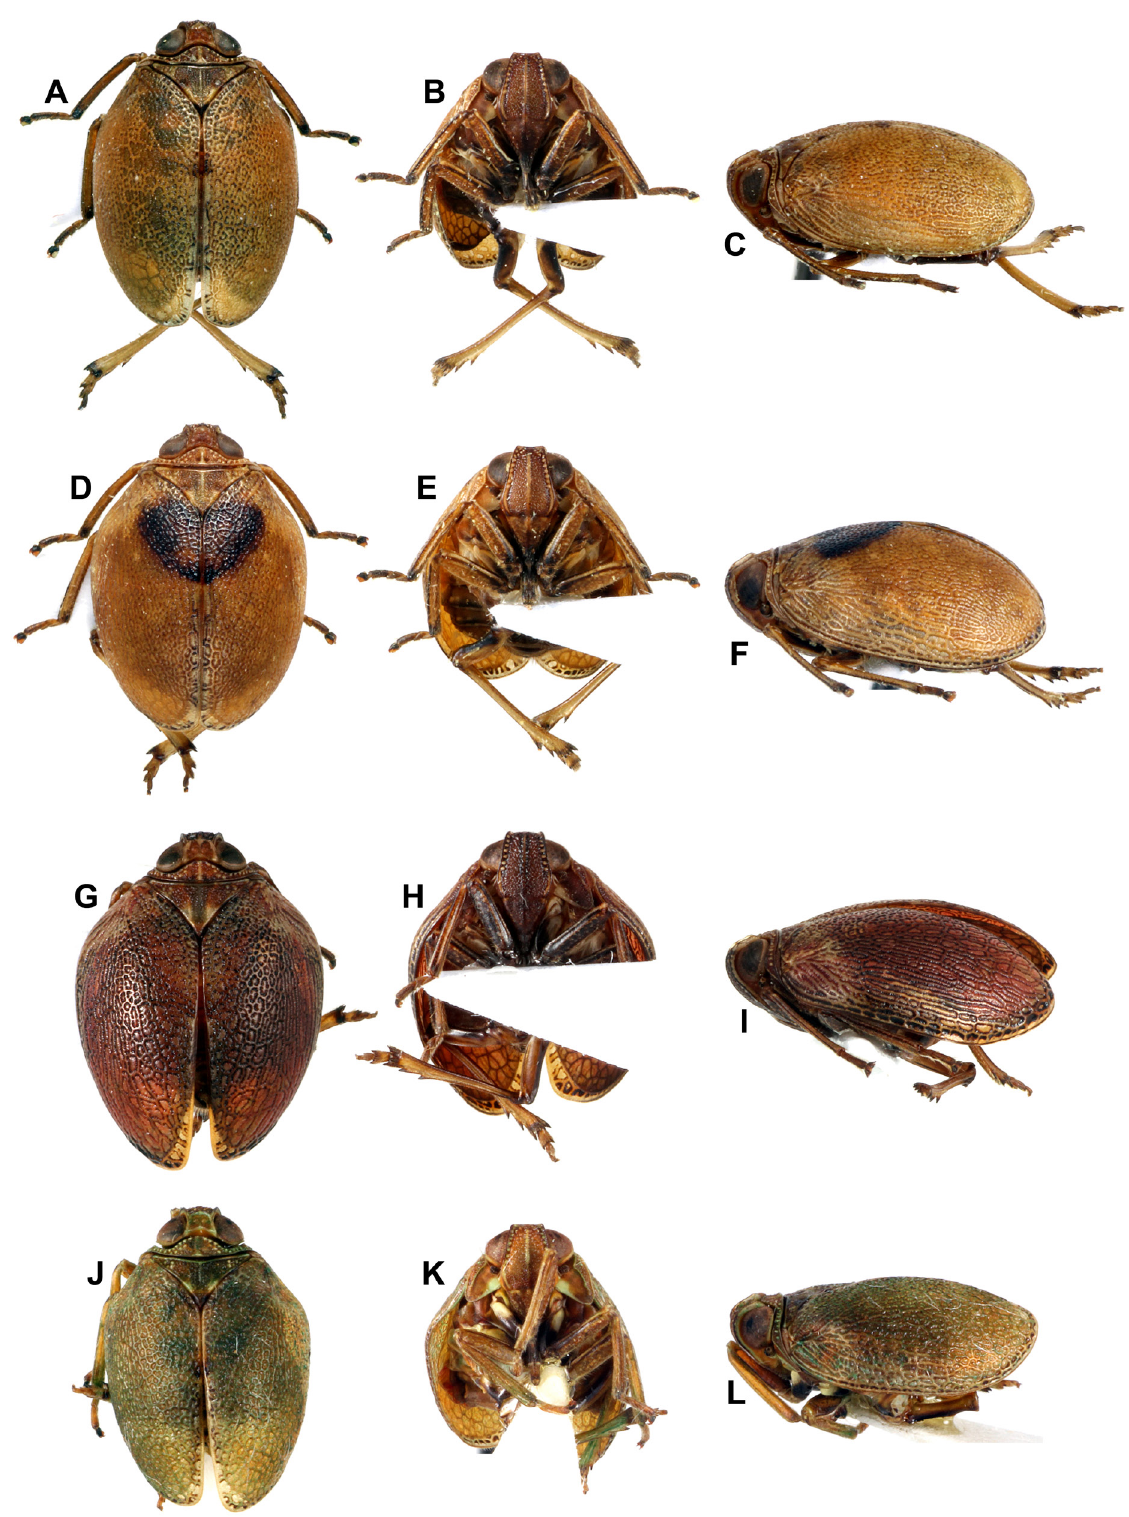
Fig. 6. Gergithoides ♀♀, unidentified species from Vietnam. A–C . Specimen from Ba Vi National Park (LT = 6.0 mm). D–F . Specimen from Ba Vi National Park (LT = 6.0 mm). G–I . Specimen from Da Krong Nature Reserve (LT = 6.6 mm). J–L . Specimen from Bidoup-Nui Ba National Park (LT = 5.9 mm). A, D, G, J = dorsal view; B, E, H, K = ventral view; C, F, I, L =